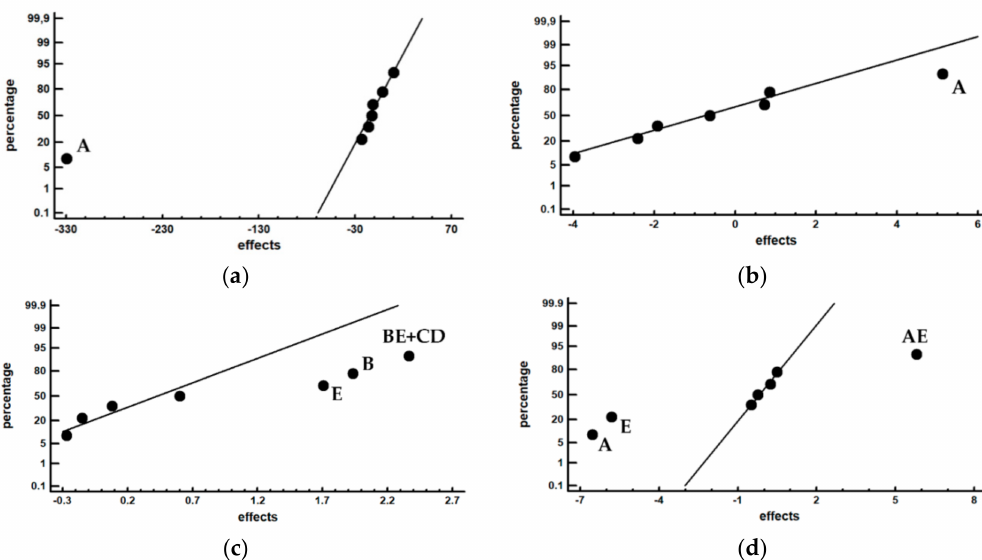
Figure 4. E ff ects on a normal probability plot. Those factors that have a significant e ff ect on hardness, the percentage of carbides and the percentage of retained austenite are shown. ( a ) Hardness; ( b ) Cr 7 C 3 carbides; ( c ) vanadium carbides; ( d ) retained